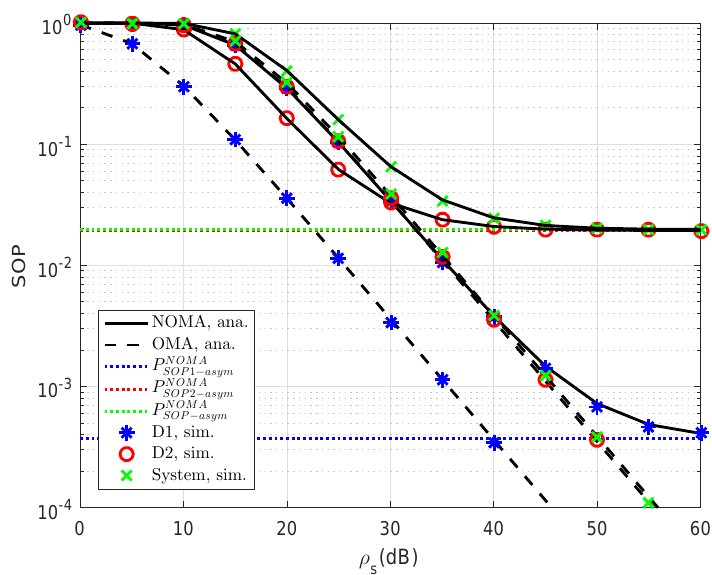
Figure 8. Comparison study of SOP in several cases versus ρ S = ρ R ( λ D 1 = λ D 12 = λ SRk = λ kD 2 = λ E = 1, ρ E = − 8 dB, K = 1, R 1 = R 2 = 1).